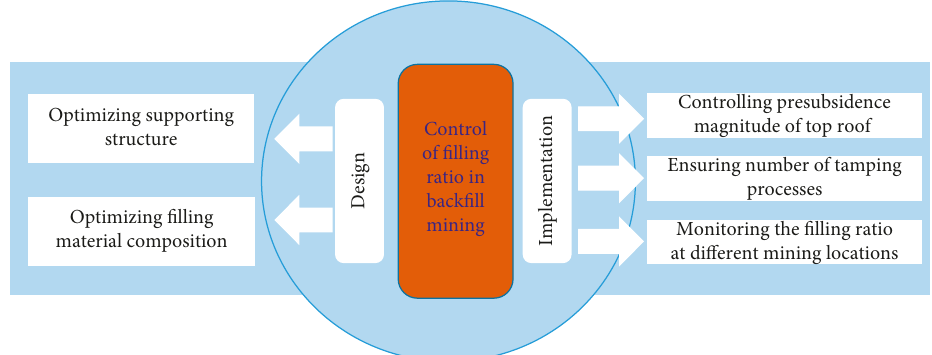
Figure 11: Control method of backfill body